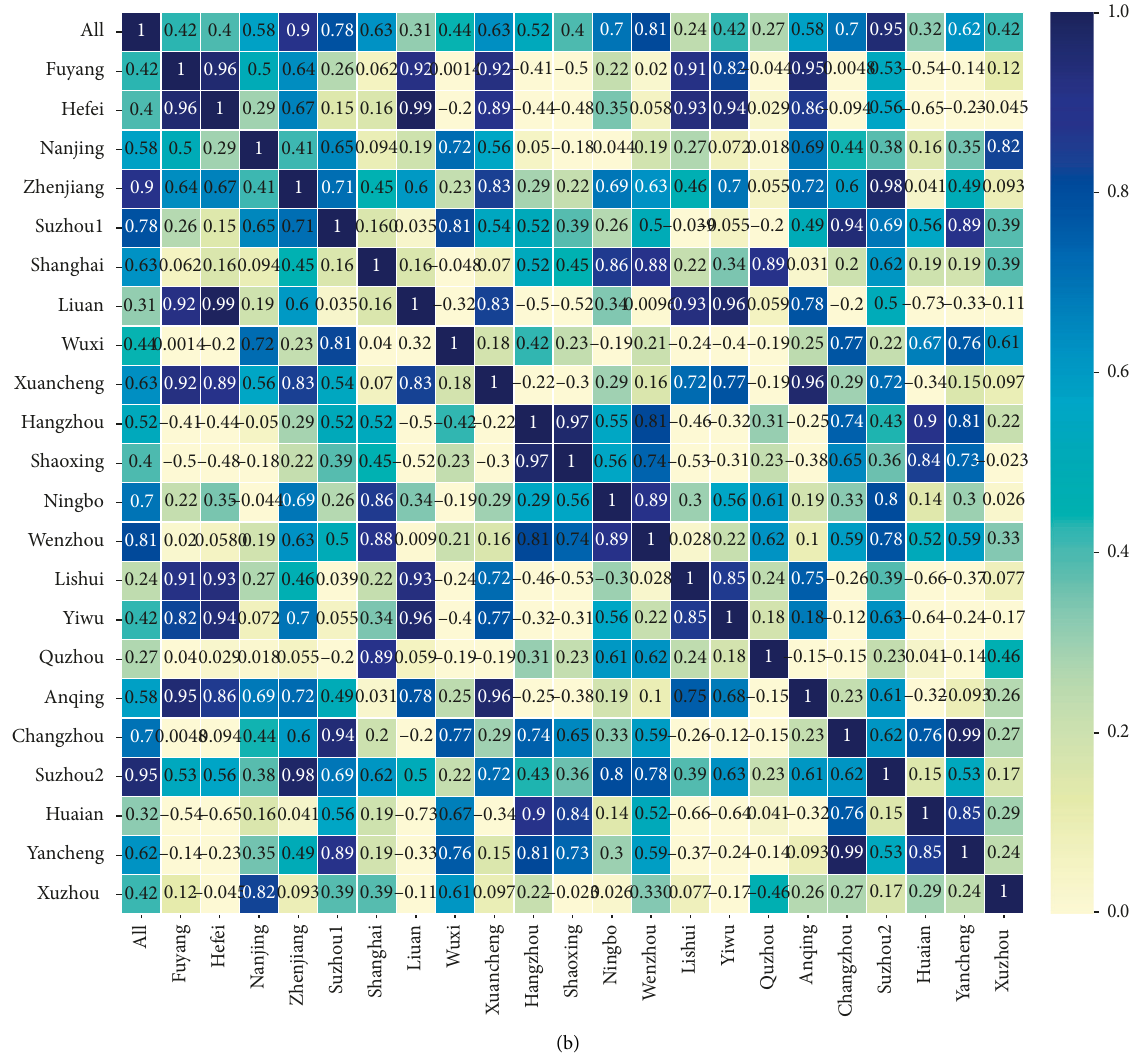
Figure 12: Matrix diagram of relevance coefficient of corporate development of cities in the (a) five years before 2007 and the (b) five years after